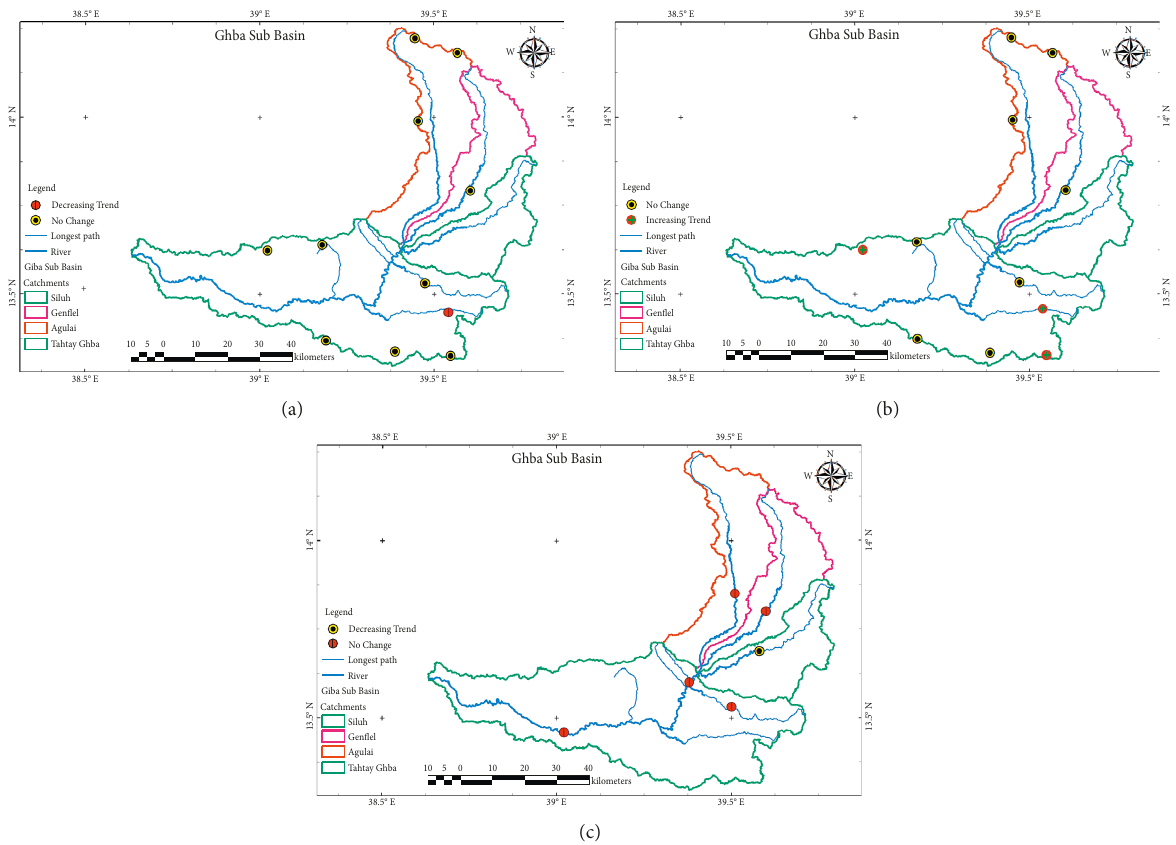
Figure 11: Location of hydroclimatic stations with increasing (+), decreasing ( − ), and no change (0) trends on annual rainfall (a), temperature (b), and streamflow (c).